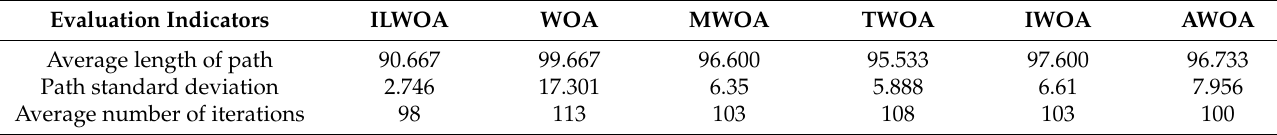
Table 6. Experimental results of Environment 3